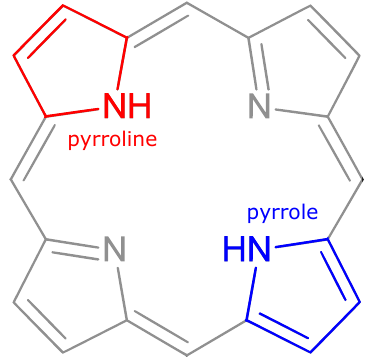
Figure 14. Structure of porphyrin with pyrrolic and pyrrolinic sub- units